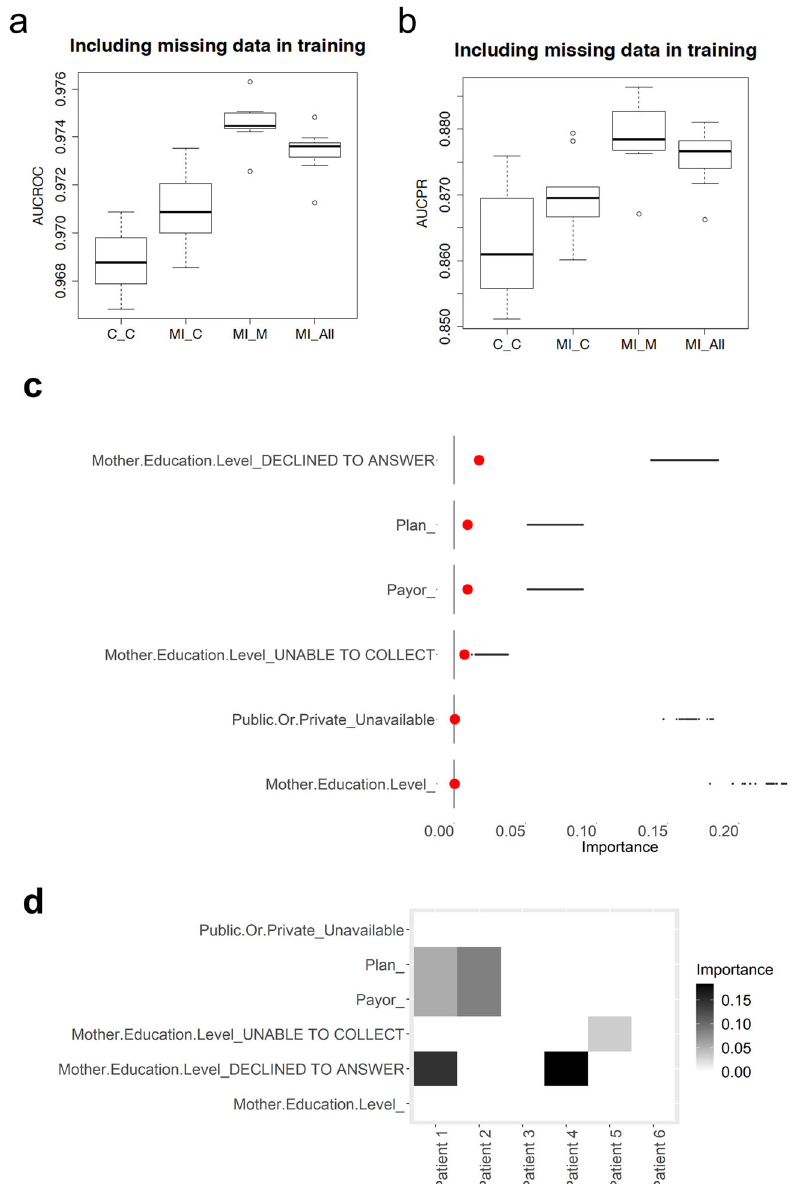
Fig. 3 Performance of deep learning models predicting no-shows. a AUROC of our deep learning model predicting no-shows for (a) the model trained only on records with complete information and tested on records with complete information, labeled C_C, corresponding to the case of list-wise deletion (b) the model trained on both records with complete and missing information, and tested on records with complete information, labeled MI_C, (c) the model trained on both records with complete and missing information, and tested on records with missing information, labeled MI_M, and (d) the model trained both records with complete and missing information, and tested on records with complete and missing information, labeled MI_All. b AUPRC our deep learning model predicting no-shows for the above four experiment settings. c Feature importance of each missing information indicator variable, where the top 10 features are shown. d Examples of importance of each missing indicator feature in predicting no-shows in different visits of patients. Examples of six visits are